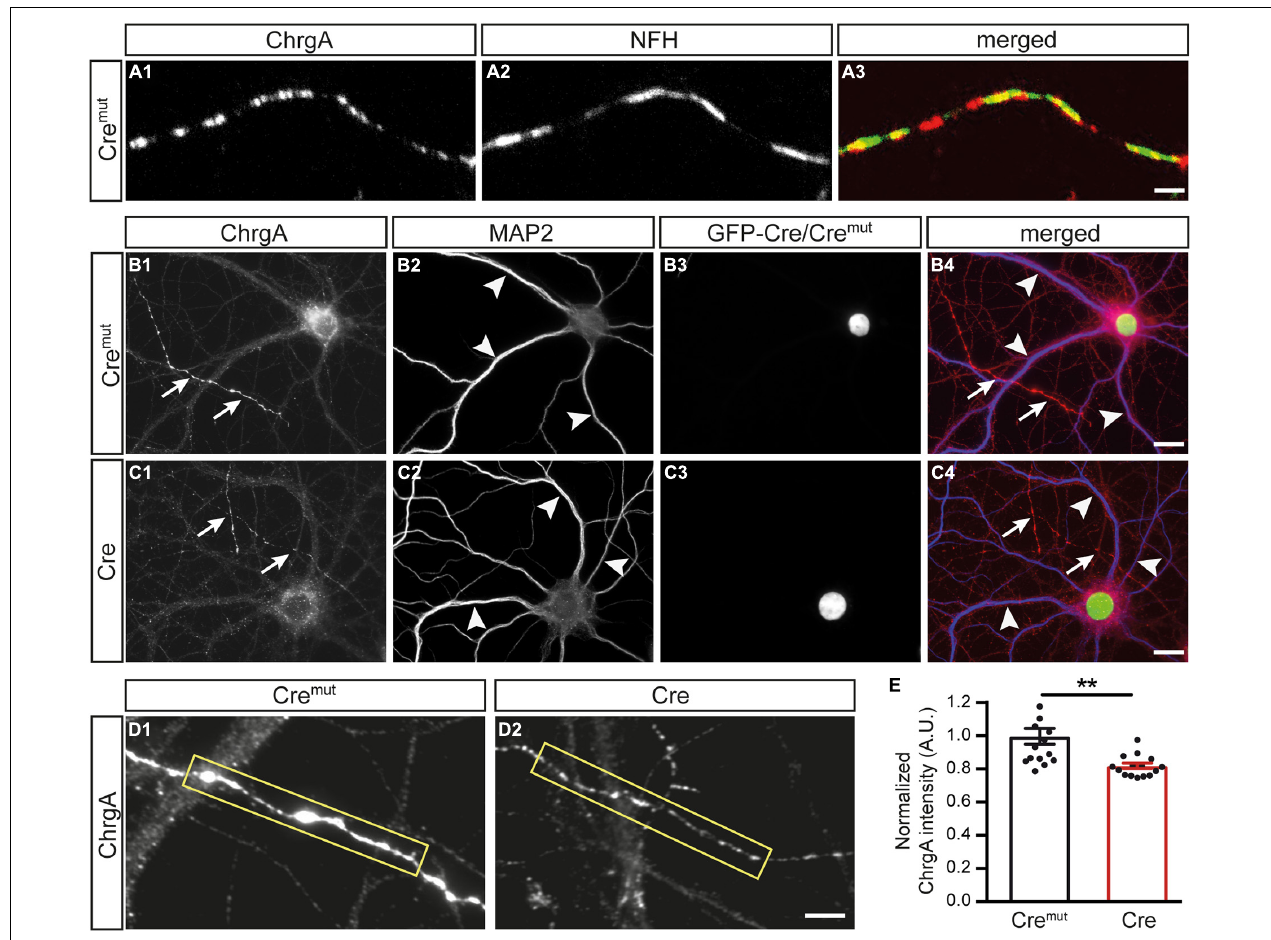
FIGURE 1 | Diminished chromogranin A (ChrgA) levels in β -neurexins- ( β -Nrxns-) deficient hippocampal neurons. (A) Primary hippocampal neurons from floxed β -Nrxn knock-in ( β -KI) mice were transduced with lentivirus expressing inactive Cre recombinase (Cre mut ) and immunostained at DIV18 with anti-ChrgA (A 1 ) and anti-neurofilament H (NFH, A 2 ). Merged image (A 3 ) shows the presence of the dense-core vesicle (DCV) marker ChrgA in axons. Scale bar: 3 µ m. (B,C) Cultured neurons as in panel (A) but colabeled for ChrgA (B 1 ,C 1 ) and the dendritic marker MAP2 (B 2 ,C 2 ) . Successful transduction of neurons with lentivirus is demonstrated by nuclear expression of inactive Cre mut or active Cre recombinase (Cre) fused to GFP (B 3 ,C 3 ) . Merged images (B 4 ,C 4 ) show the exclusion of ChrgA (arrows) from MAP-positive dendrites (arrowheads) independent of the presence of β -Nrxn. Scale bars: 20 µ m. (D) Representative images of ChrgA-positive axons of Cre mut control (D 1 ) and Cre transduced conditional knockout (cKO) (D 2 ) neurons from experiments as in panel (A) that were used for measurements of fluorescence intensity (yellow boxes). Note that the fluorescence intensity appears to be overall reduced in β -Nrxn-deficient axons with no change in the labeling pattern and without apparent ectopic accumulation. Scale bar: 4 µ m. (E) Histogram comparing the ChrgA fluorescence intensity over axons from Cre mut control (black bars) and β -Nrxn-deficient Cre neurons (red bars) as shown in panel (D) . Intensities (AU = arbitrary units) were normalized to control values. Data are shown as mean ± SEM, measurements are based on n = 15 axonal regions from the three independent cultures per genotype; significance difference indicated as ** p < 0.01, two-tailed unpaired t -test.